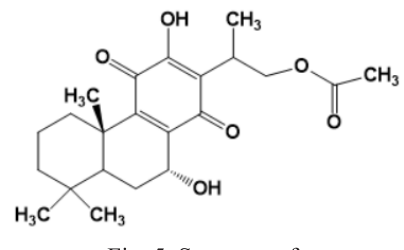
16-acetoxy-7α-hydroxyroyleanone isolate (syn.